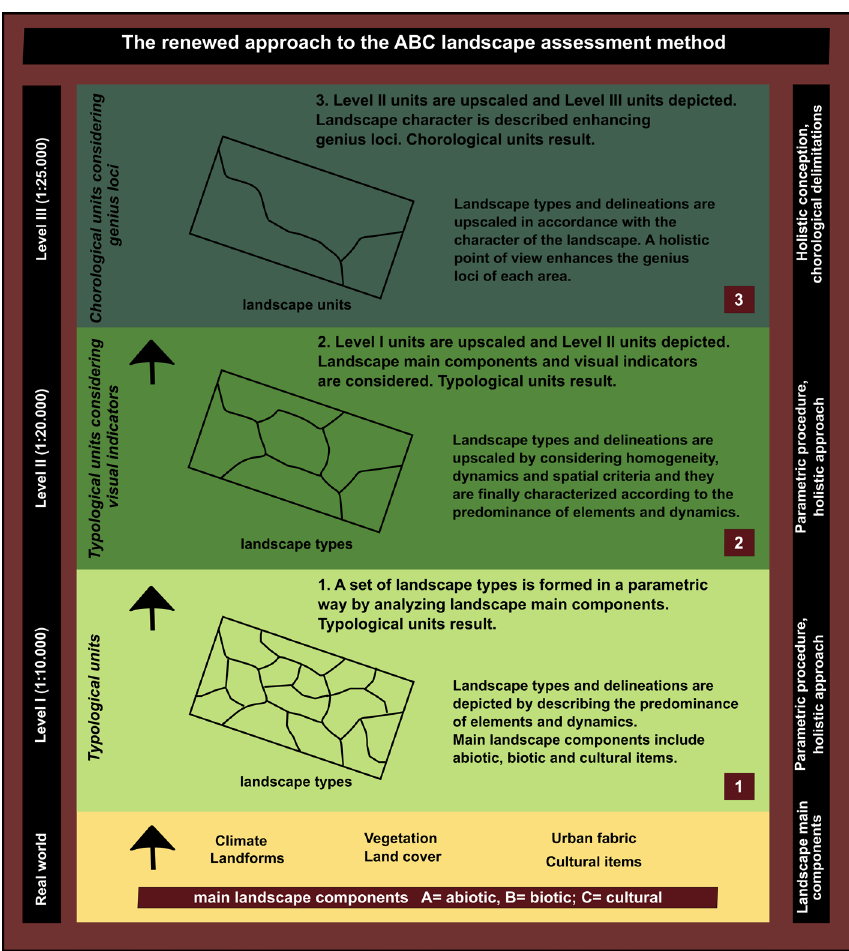
Figure 2: Overview of the renewed ABC